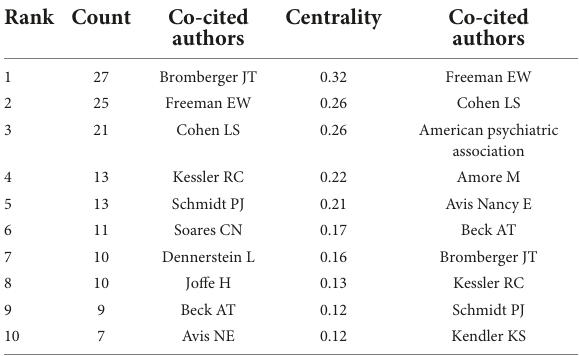
TABLE 4 Top 10 co-cited authors related to